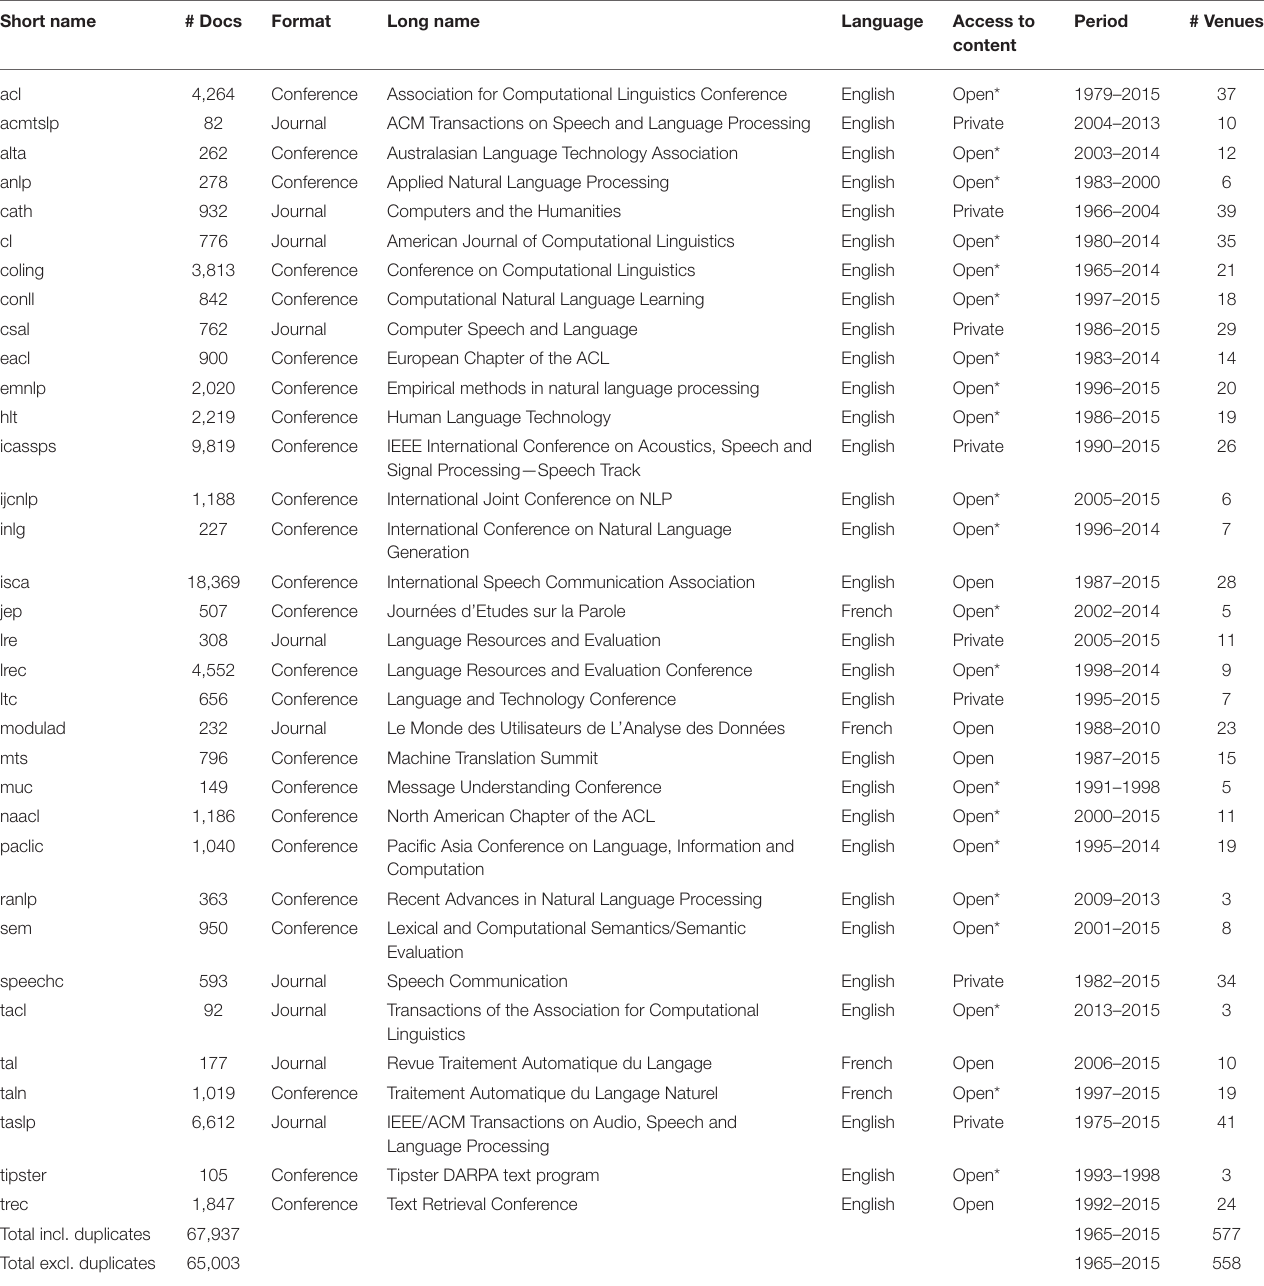
TABLE 1 | The NLP4NLP Corpus of Conferences (24) and Journals